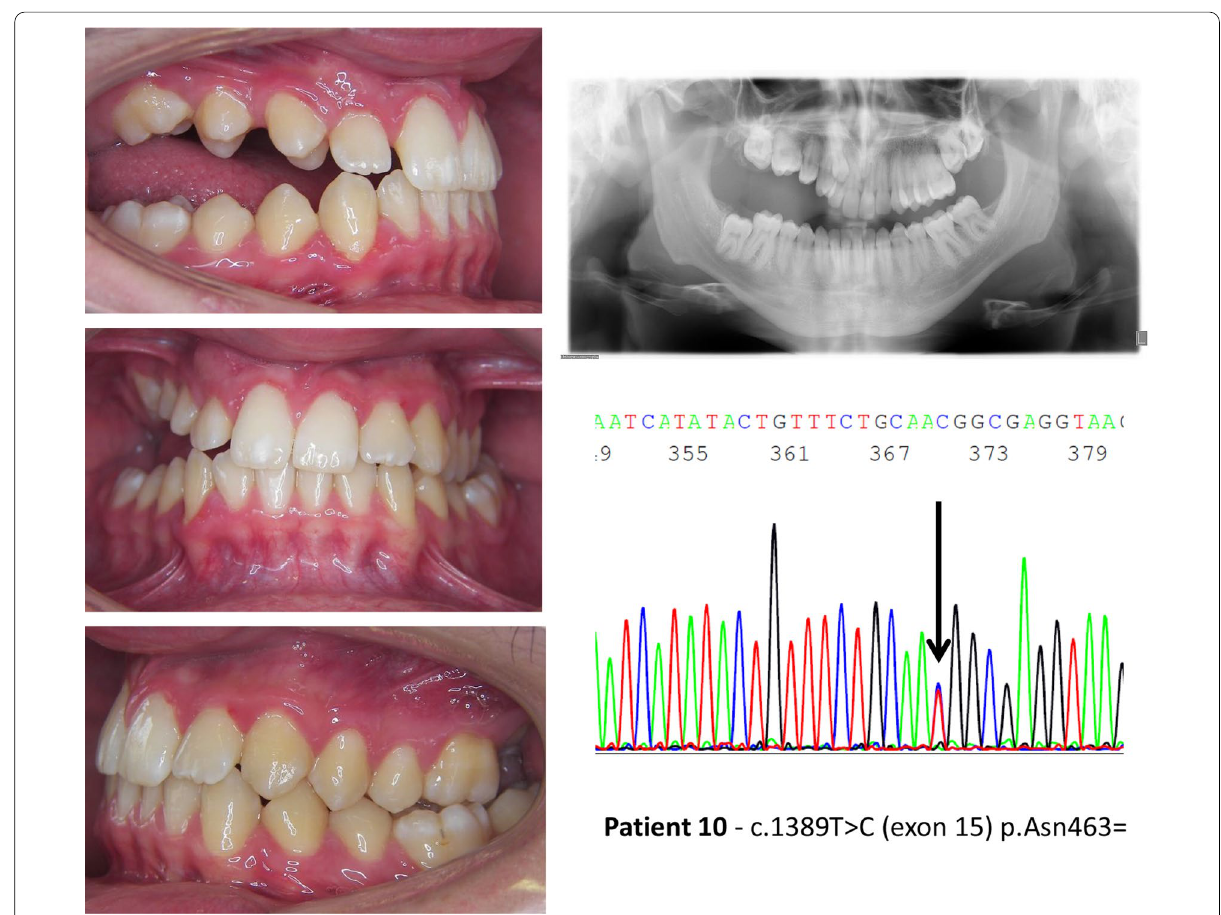
Fig. 4 Clinical features and genetic findings of patient 10 with PFE and an intronic PTH1R